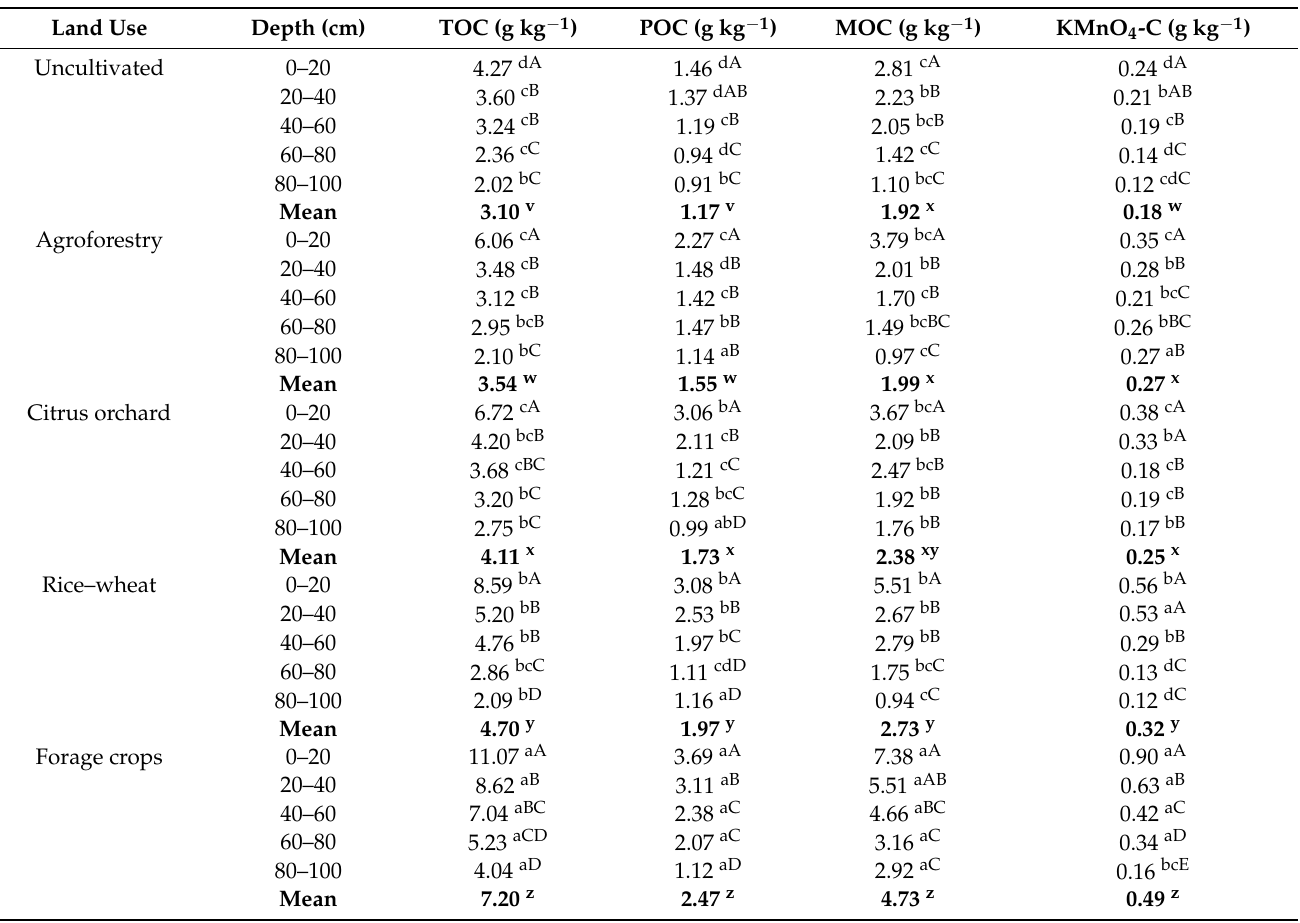
Table 3. Depth-wise distribution of total organic carbon (TOC), particulate organic carbon (POC), mineral-associated organic carbon (MOC), and KMnO 4 oxidizable carbon (KmnO 4 -C) as affected by different land use systems in a hot, arid